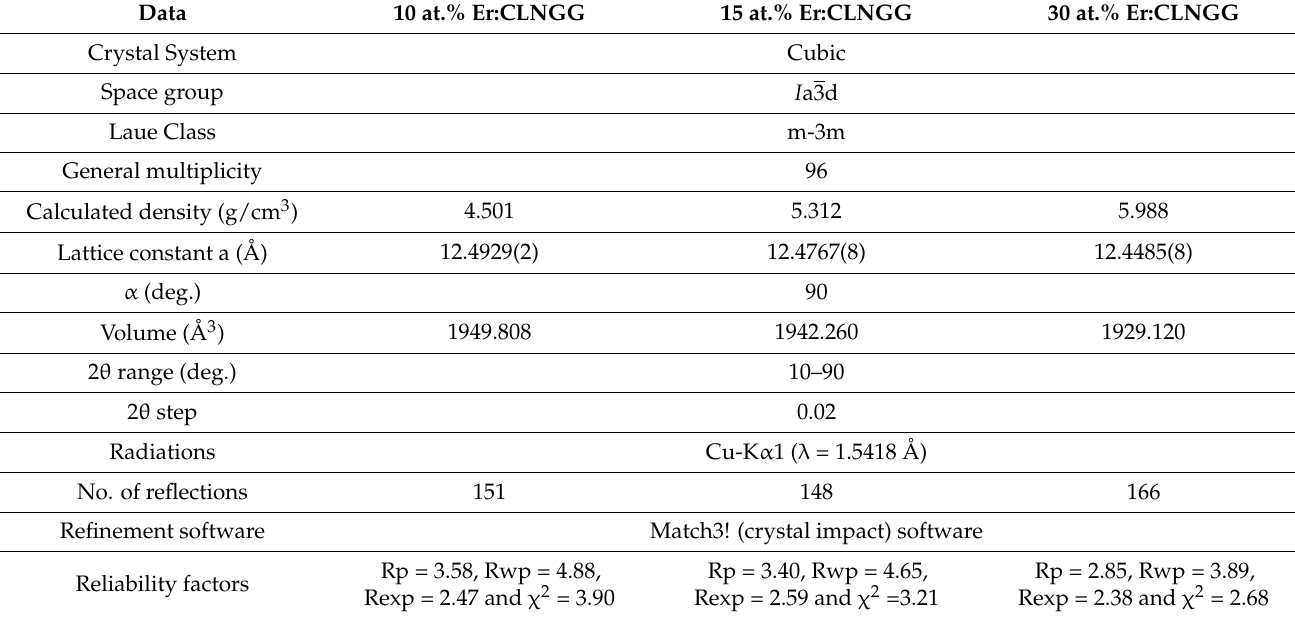
Table 1. Crystallographic data and refinement parameters for 10, 15 and 30 at.% Er:CLNGG. Data 10 at.%